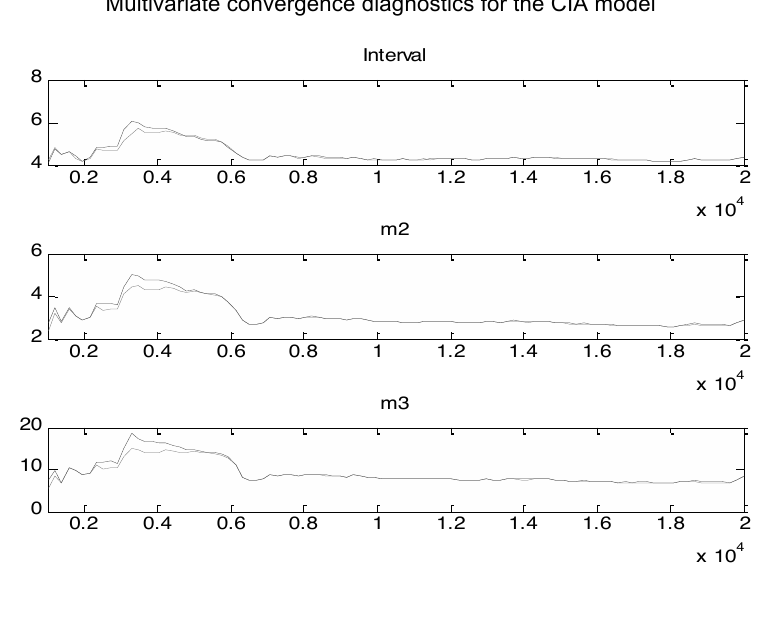
Multivariate convergence diagnostics for the CIA